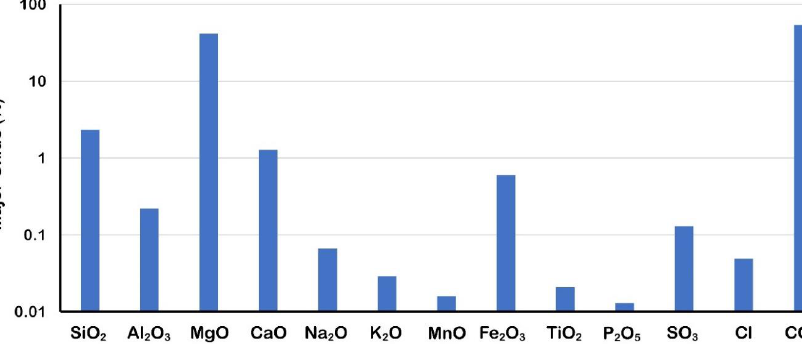
Figure 4. Major oxide contents (%) of the stromatolite samples from Lake Salda.